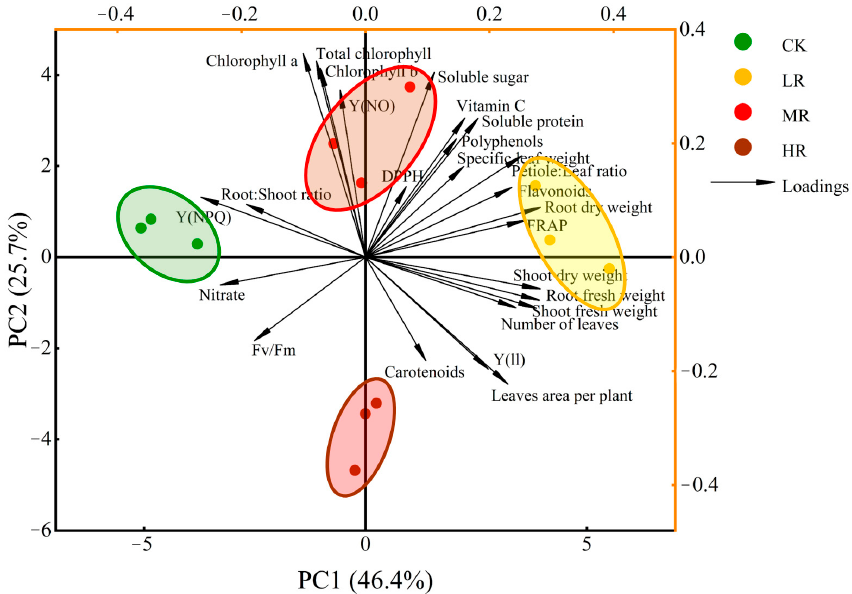
Figure 8. CK: only white light, LR: red:white = 1:2, MR = red:white = 1:1, LR = red:white = 2:1. Principal component analysis of pak choi grown under the different ratios of red and white light treatments.